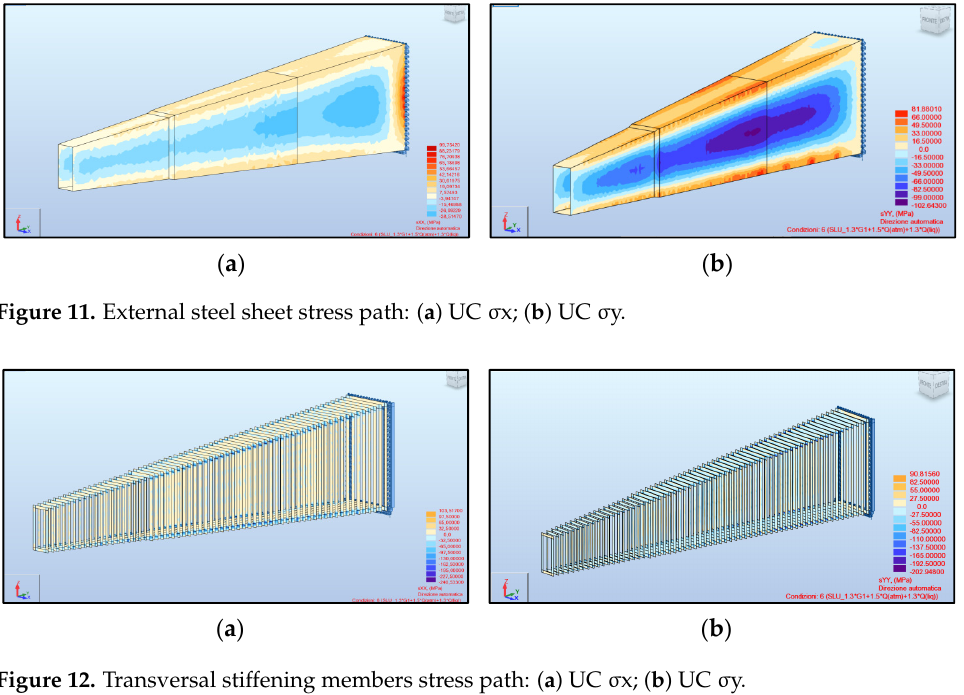
Figure 10. Internal steel sheet stress path: ( a ) UC σ x; ( b ) UC σ y.